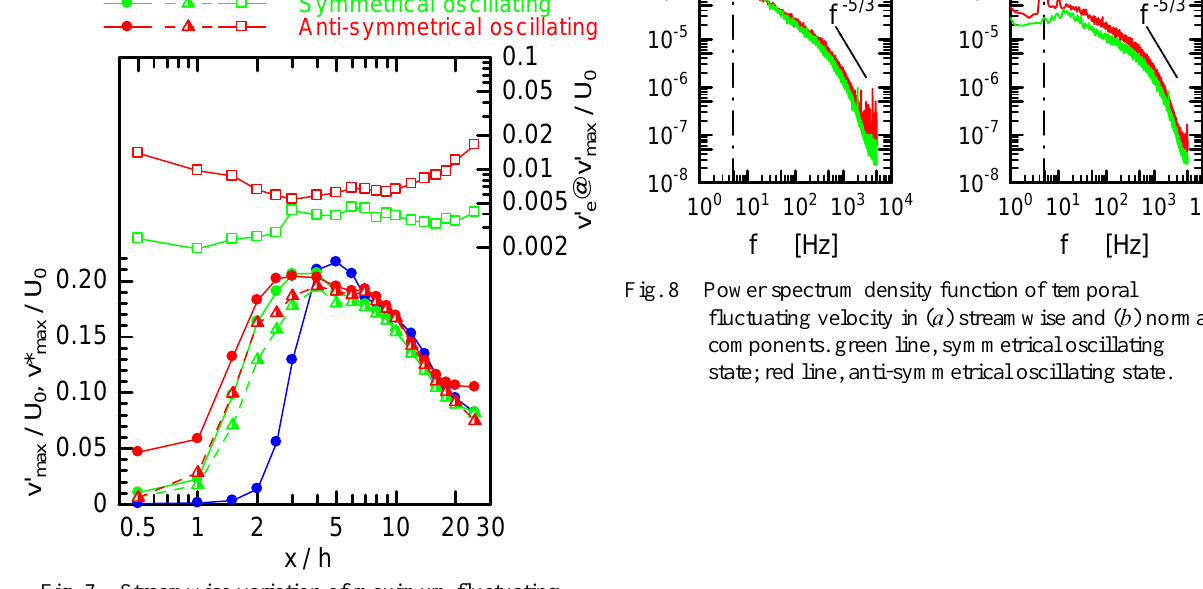
Fig. 6 Streamwise variation of maximum fluctuating velocities in the streamwise component